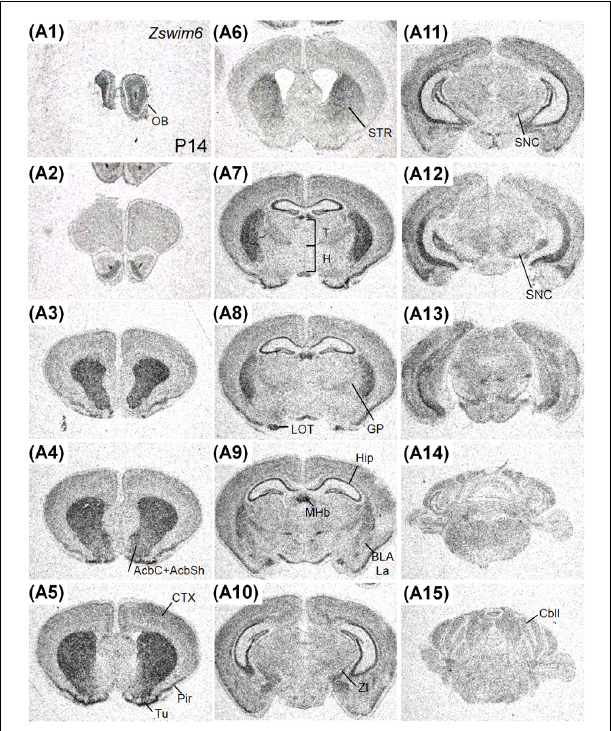
FIGURE 8 | Zswim6 mRNA expression pattern in P14 mouse forebrain. Zswim6 mRNA signals were detected from rostral to caudal levels at P14 (A1–A15) . AcbC, nucleus accumbens, core; AcbSh, nucleus accumbens, shell; BLA, basolateral amygdala; Cbll, cerebellum; CTX, cortex; GP, globus pallidus; H, hypothalamus; Hip, hippocampus; La, lateral amygdaloid nucleus; LOT, nucleus of the lateral olfactory tract; MHb, medial habenular nucleus; OB, olfactory bulb; Pir, piriform cortex; SNC, substantia nigra; STR, striatum; T, thalamus; Tu, olfactory tubercle; ZI, zona incerta. ( Figures 9A1–A6 ). Zswim6 expression in the cortex was